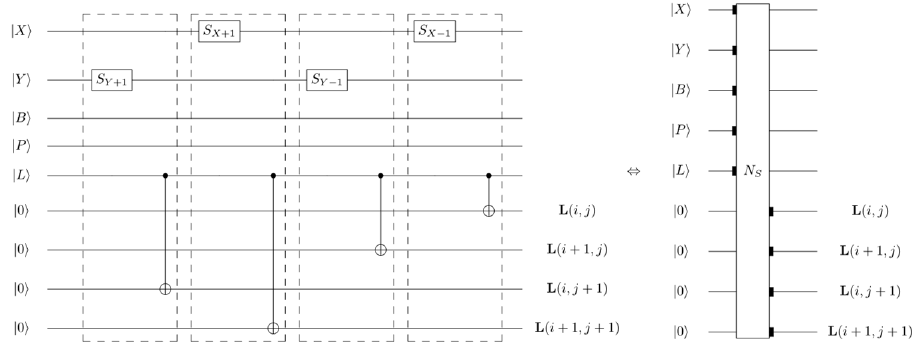
Figure 13. Obtaining of information of N p .